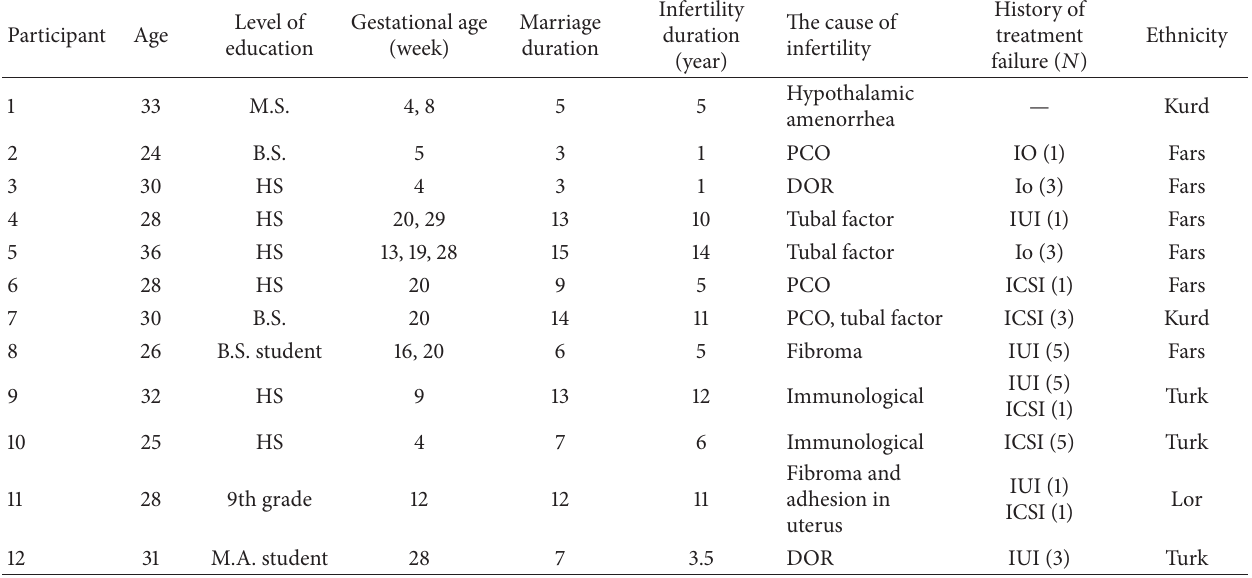
Table 1: Demographic characteristics of